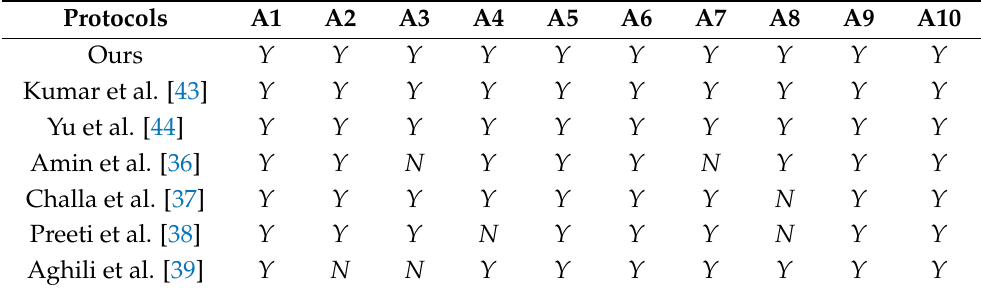
Table 3. Comparisons of security.